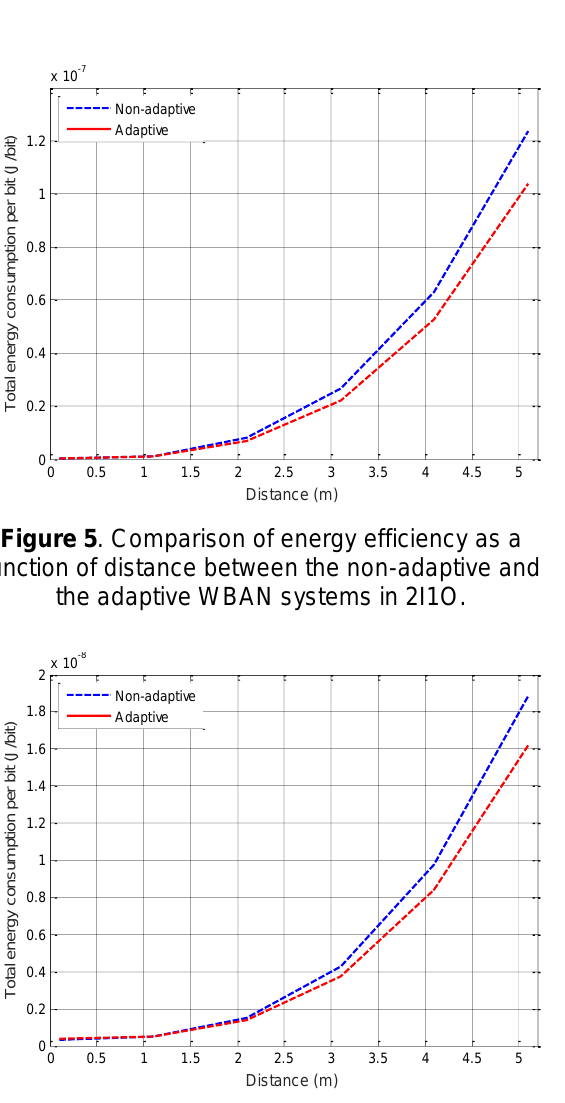
Figure 6. Comparison of energy efficiency as a function of distance between the non-adaptive and the adaptive WBAN systems in 2I2O.